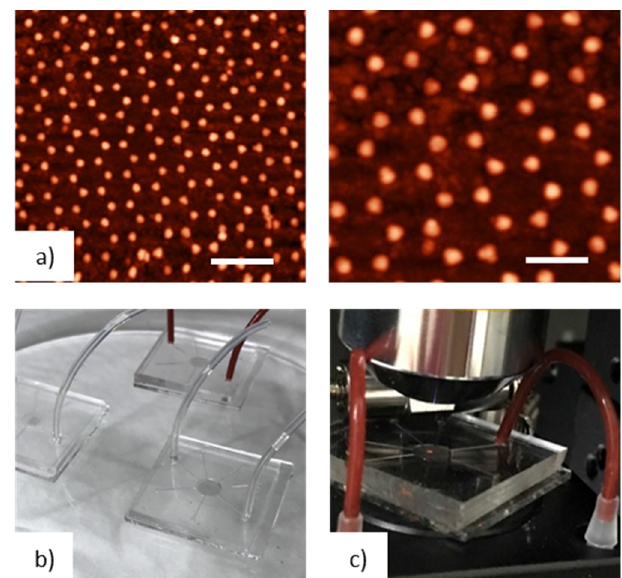
Figure 3. ( a ) AFM images at low and high magnification of Au Nano-Domes realized on glass substrates; The scale bars are 1 µ m and 500 nm, respectively. ( b ) Example of Lab on Chip (LOC) devices realized by integrating plasmonic nano-structures into PDMS microfluidic channels; LOC devices have been exploited for real-time sensing measurements using the setup reported in ( c